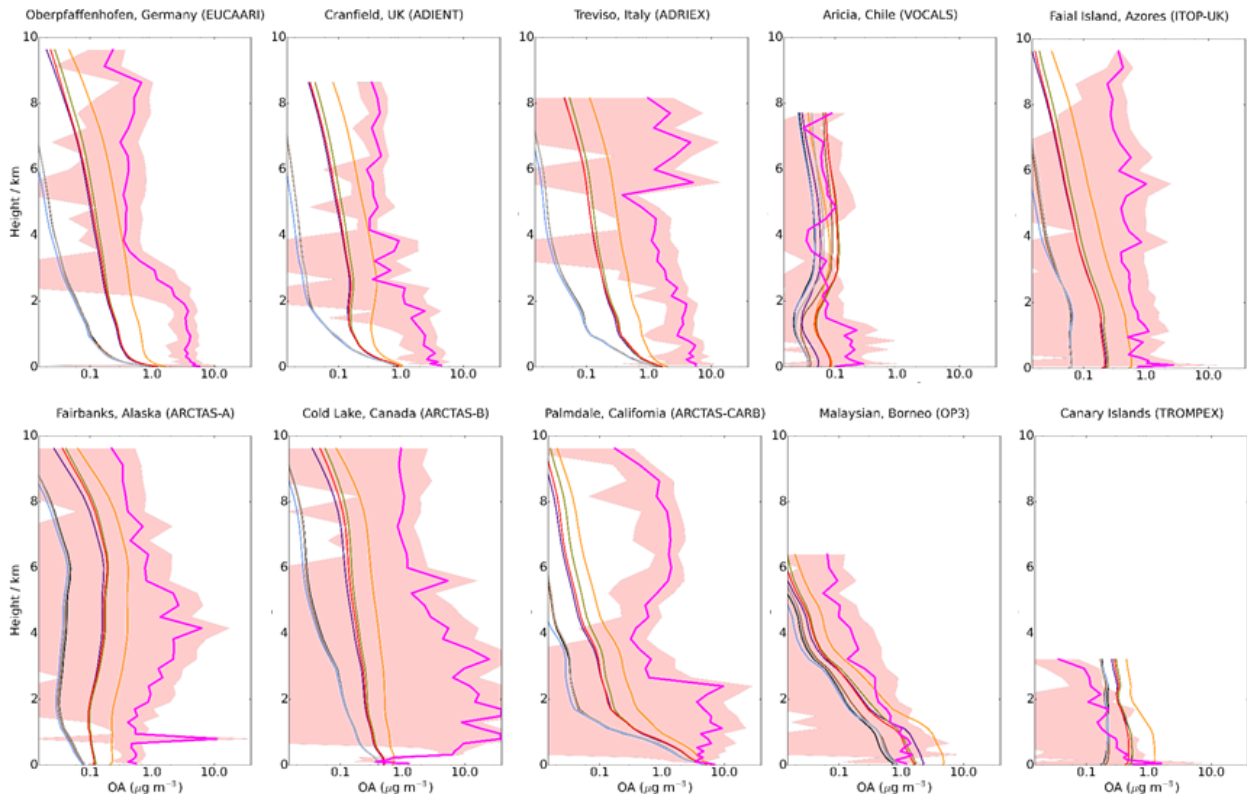
Figure 14. Mean vertical profile of OA (µgm − 3 ) for 10 field campaigns with the mean UKCA for the simulations described in Table 2. The SD of the binned observations at each model layer are shown (peach shaded area). Colours used are identical to Fig. 13.